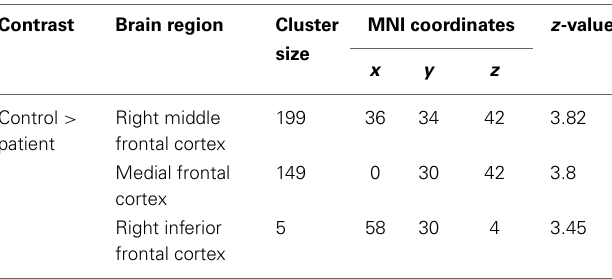
Table 3 | Decreased FC clusters in aphasic patients compared with controls ( P < 0 . 05, using FWE correction at cluster level).